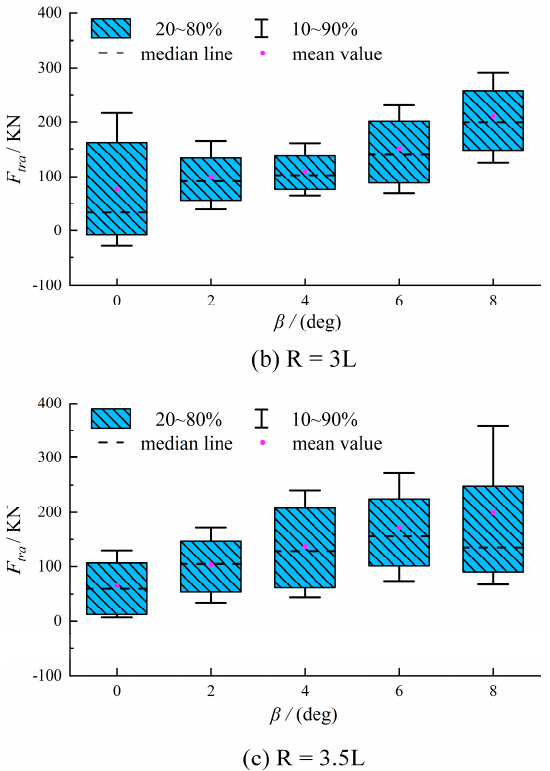
Figure 18. Box plot of Ftra under different drift angles.